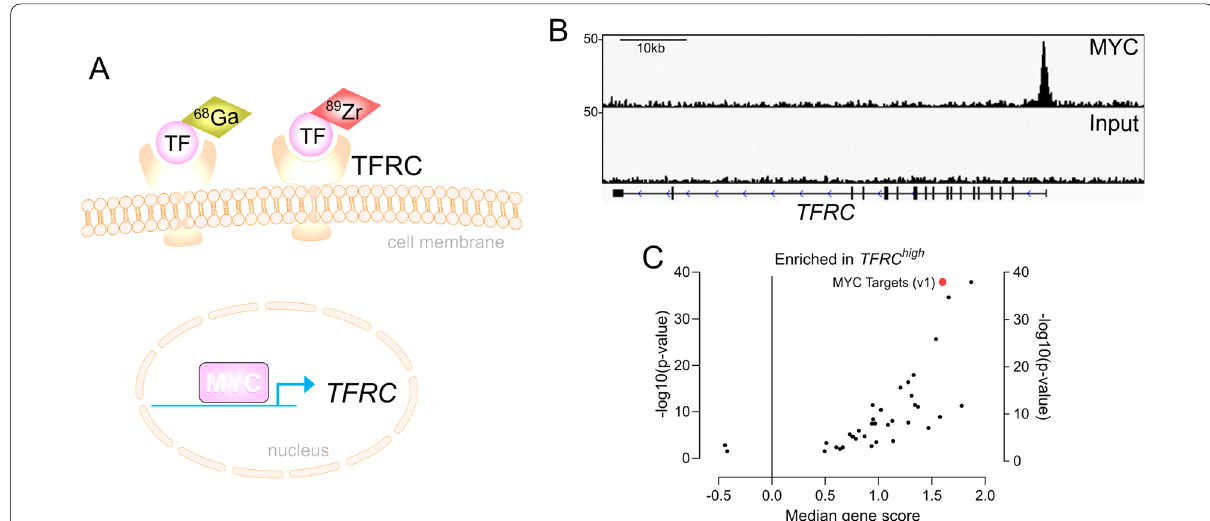
Fig. 2 Imaging of MYC. A Scheme for non-invasive annotating the MYC status. The TFRC gene is a MYC target. The Transferrin receptor can be imaged with a radiotracer, here 89 Zr-labeled transferrin (TF) or 68 Ga-citrate, which binds transferrin (TF). Overexpression of MYC leads to increased TFRC expression and augmented PET signal. B MYC and control Input ChIP-Seq data of human PDAC cells (MiaPaCa-2) published by Bhattacharyya et al. 2020 [36], were analyzed for specific binding of MYC to the TFRC gene. In addition, the exon structure of the TFRC gene is depicted (black boxes). C A mRNA expression dataset of human PDAC were retrieved via the publication of Bailey et al. [22] and curated as described [52]. A gene set enrichment analysis (GSEA) of Hallmark signatures via the GeneTrial 3.0 platform [110] was conducted comparing PDACs with TFRC mRNA expression in the highest quartile (Q4) versus PDACs in the quartiles Q1, Q2, and Q3. Each dot represents a significant hallmark signature. The MYC HALLMARK (v1) signature is highlighted in